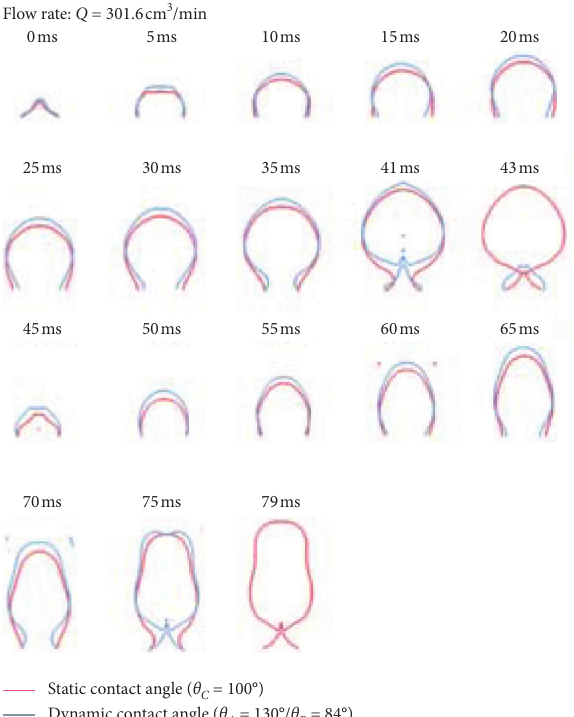
Figure 12: Comparison of profile between dynamic and static contact angles ( Q � 603.2cm 3 /min, Re � 219.07, and d 0–41ms (43 ms for the static contact angle model); second bubble, 45–75ms (77 ms for the static contact angle model); advancing contact angle period: 0–20ms for the first bubble and 45–60 ms for the second bubble; receding contact angle period: 20–35 ms for the first bubble and 60–70ms for the second